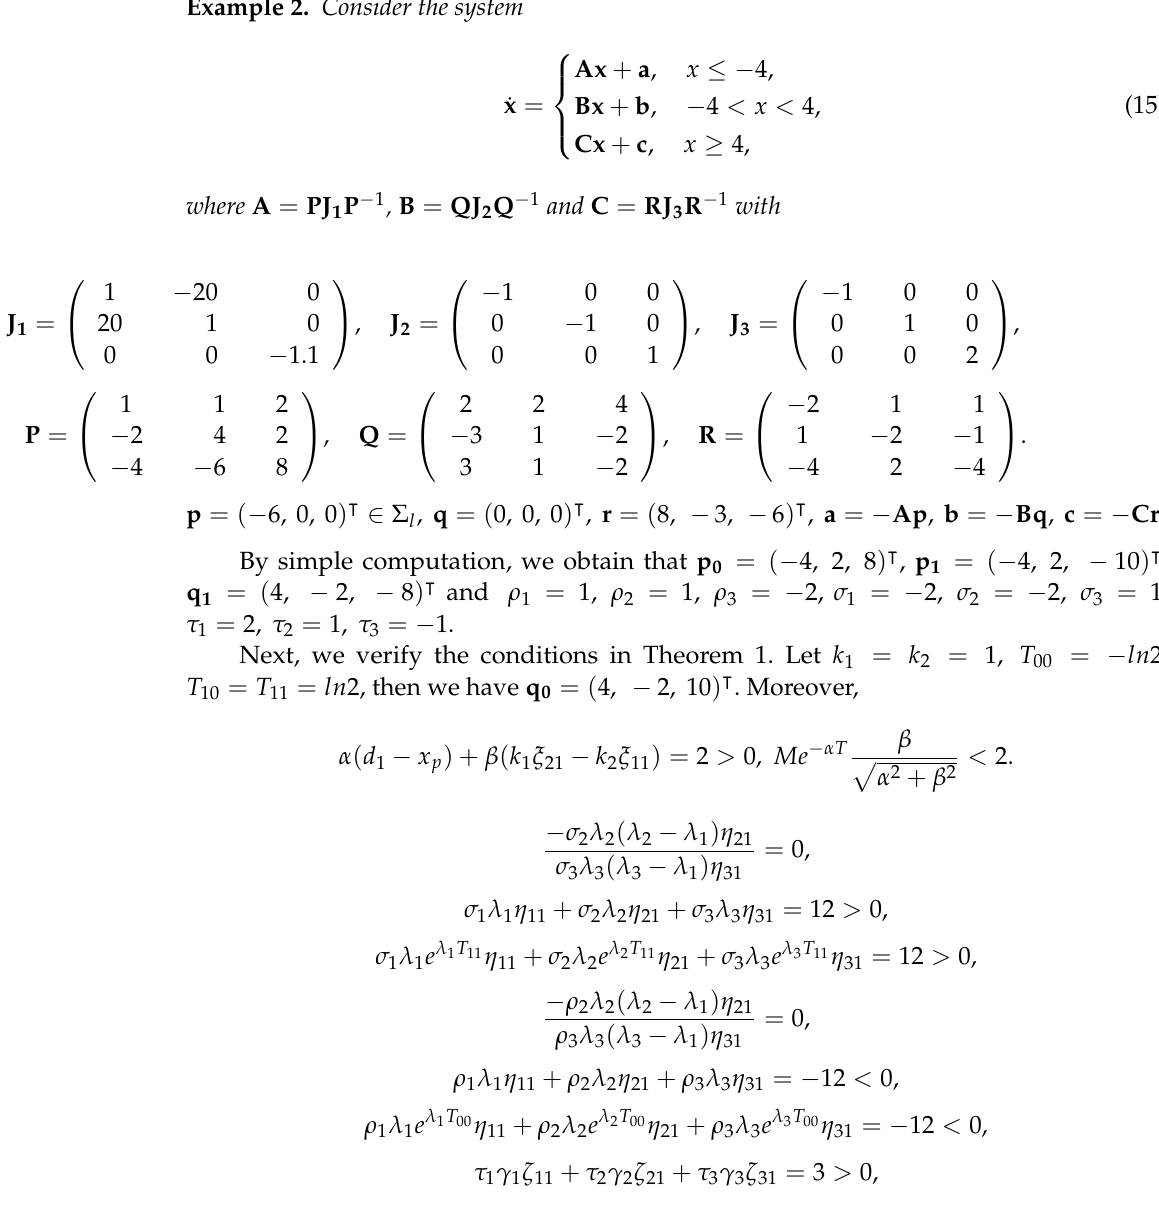
Figure 1. ( a ) The homoclinic orbit of Example 1 connects the equilibrium point p to itself which crosses the switching planes Σ Σ 2 transversally at p 0 , p 1 , q 0 , q 1 , respectively. ( b ) A chaotic invariant set of Example 1 near the homoclinic 1 and